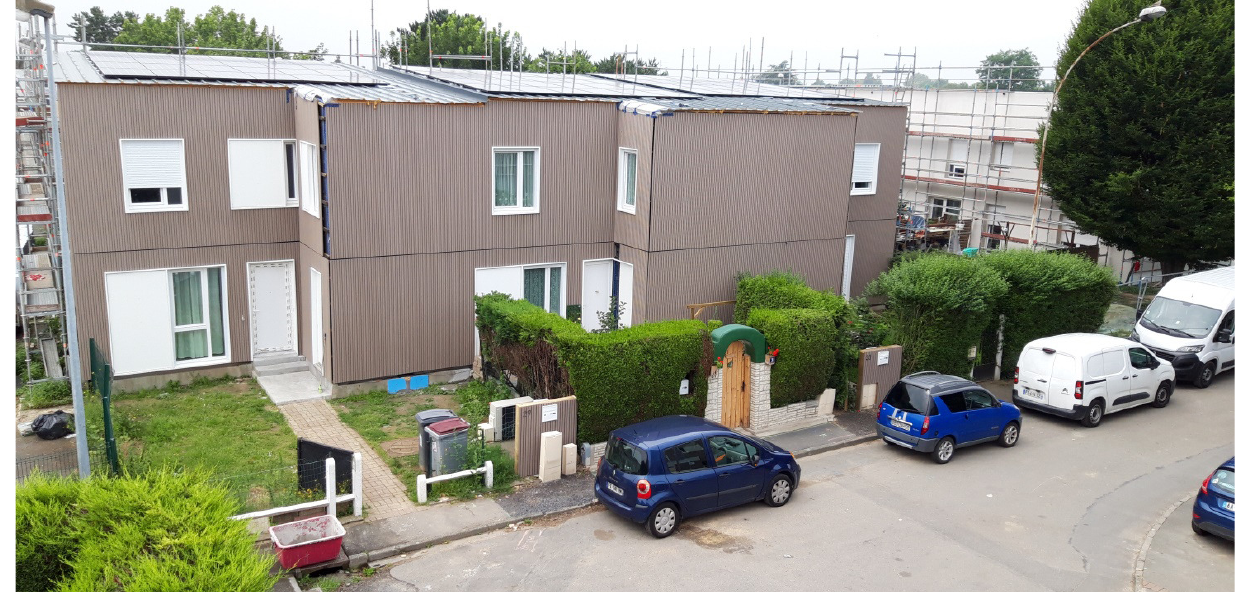
Figure 5. Wattrelos. Once the renovation is complete, residents can reappropriate their